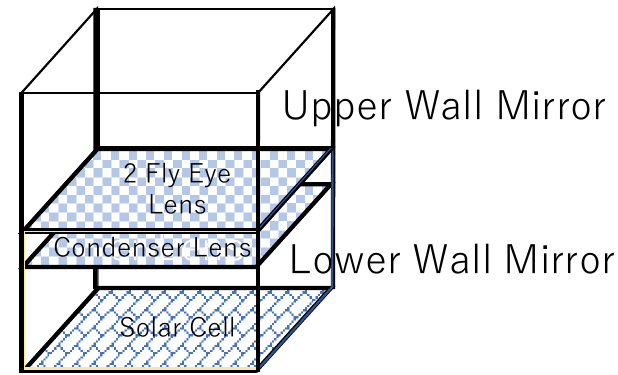
Figure 14. Fly Eye Module with Upper Wall Mirror and Lower Wall Mirror.